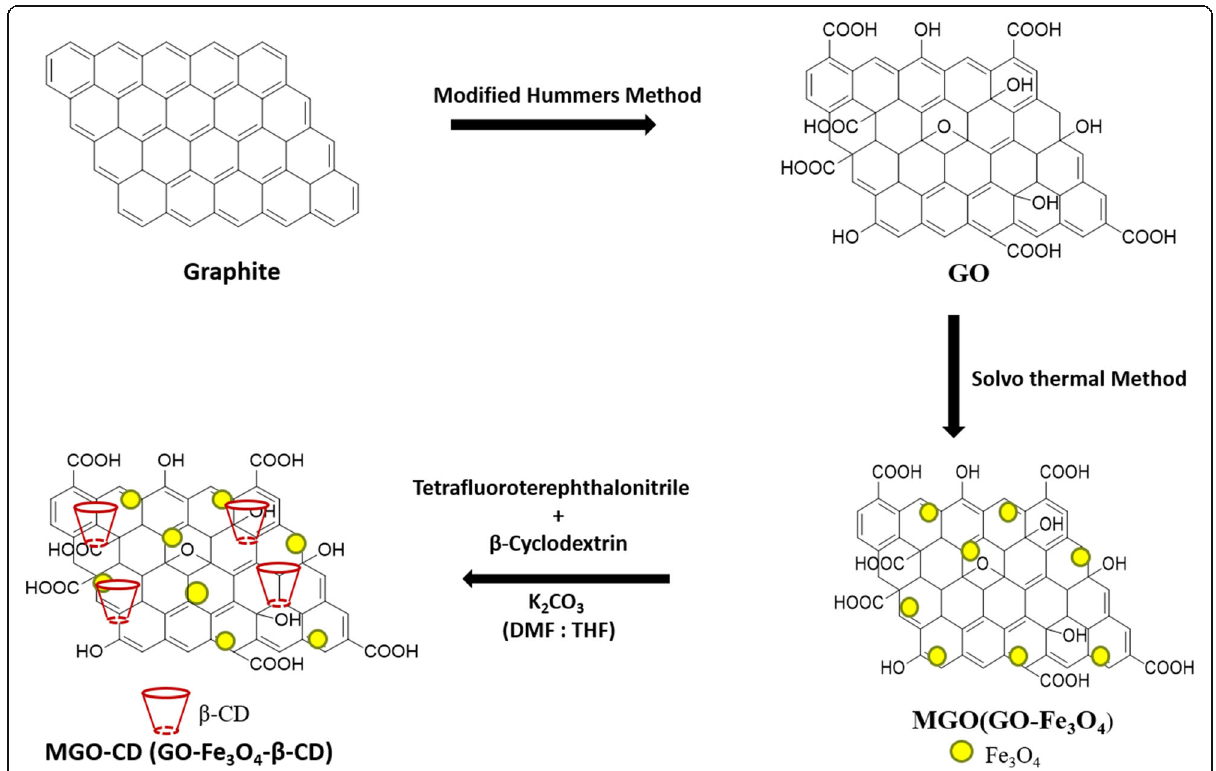
Fig. 2 Schematic illustration diagram of the synthesis of